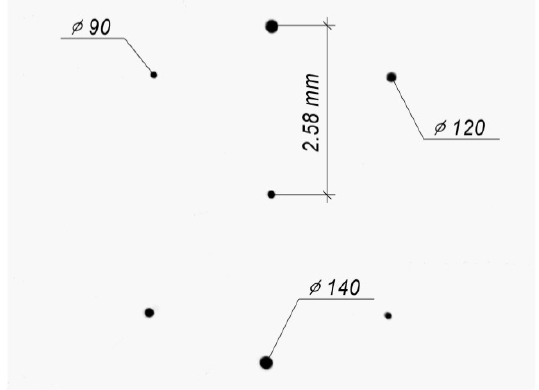
Figure 8. Image of the topology of point diaphragms.